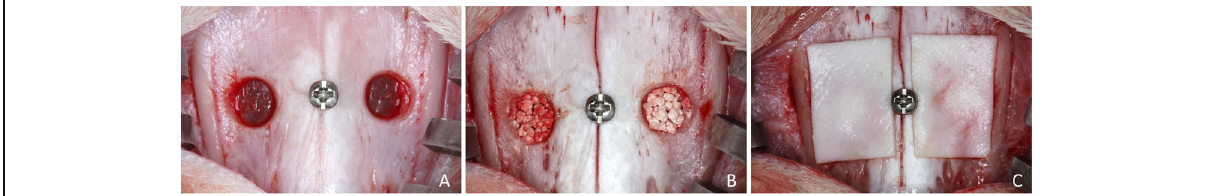
Fig. 1 Clinical view of the surgical procedures. a Rounded antrostomies were prepared with a trephine 3.5 mm in diameter, both sides of the nasal-incisal suture. b After the elevation of the sinus mucosa, dried 60% hydroxyapatite and 40% beta-tricalcium phosphate granules were grafted into the elevated space (plasma site on the